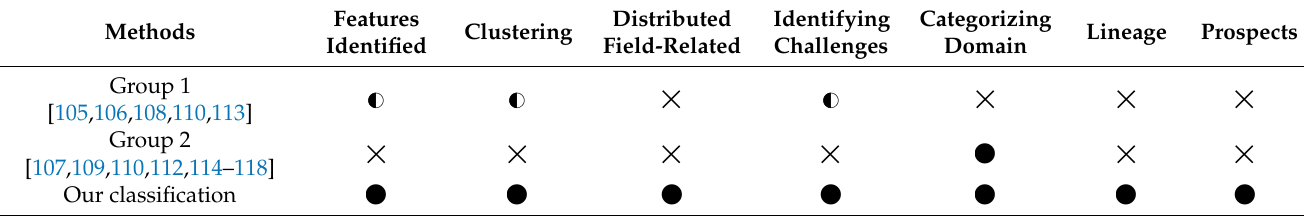
Table 4. Comparing prior taxonomic research with the proposed complete taxonomic classification.